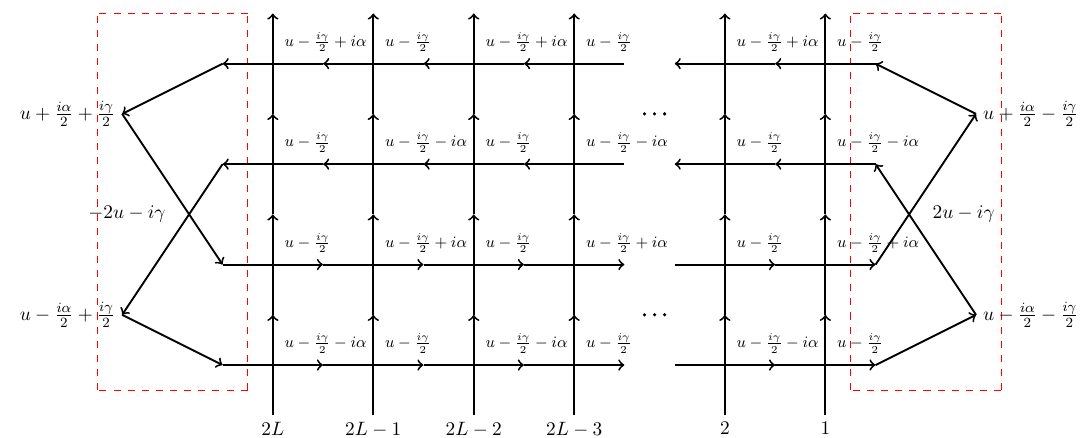
Figure 4 . Graphical representation of the swapped four-row transfer matrix for the relation of the D (2) -model. The resulting new K New -matrices (red boxes) acting on the enlarged unit cells 2 can be related to the ones of the D (2) -model via the spectral shift u → − u + iγ 2 transformations see